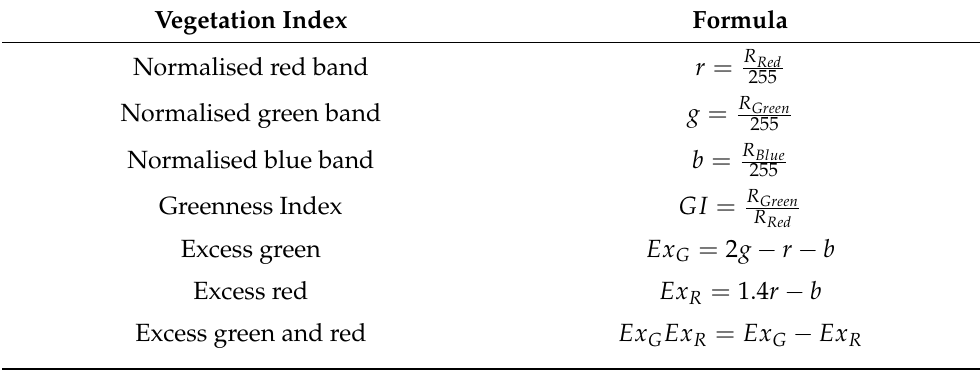
Table 2. Formulae of vegetation indices which were used in our work (adapted from [4,29,31]). Vegetation